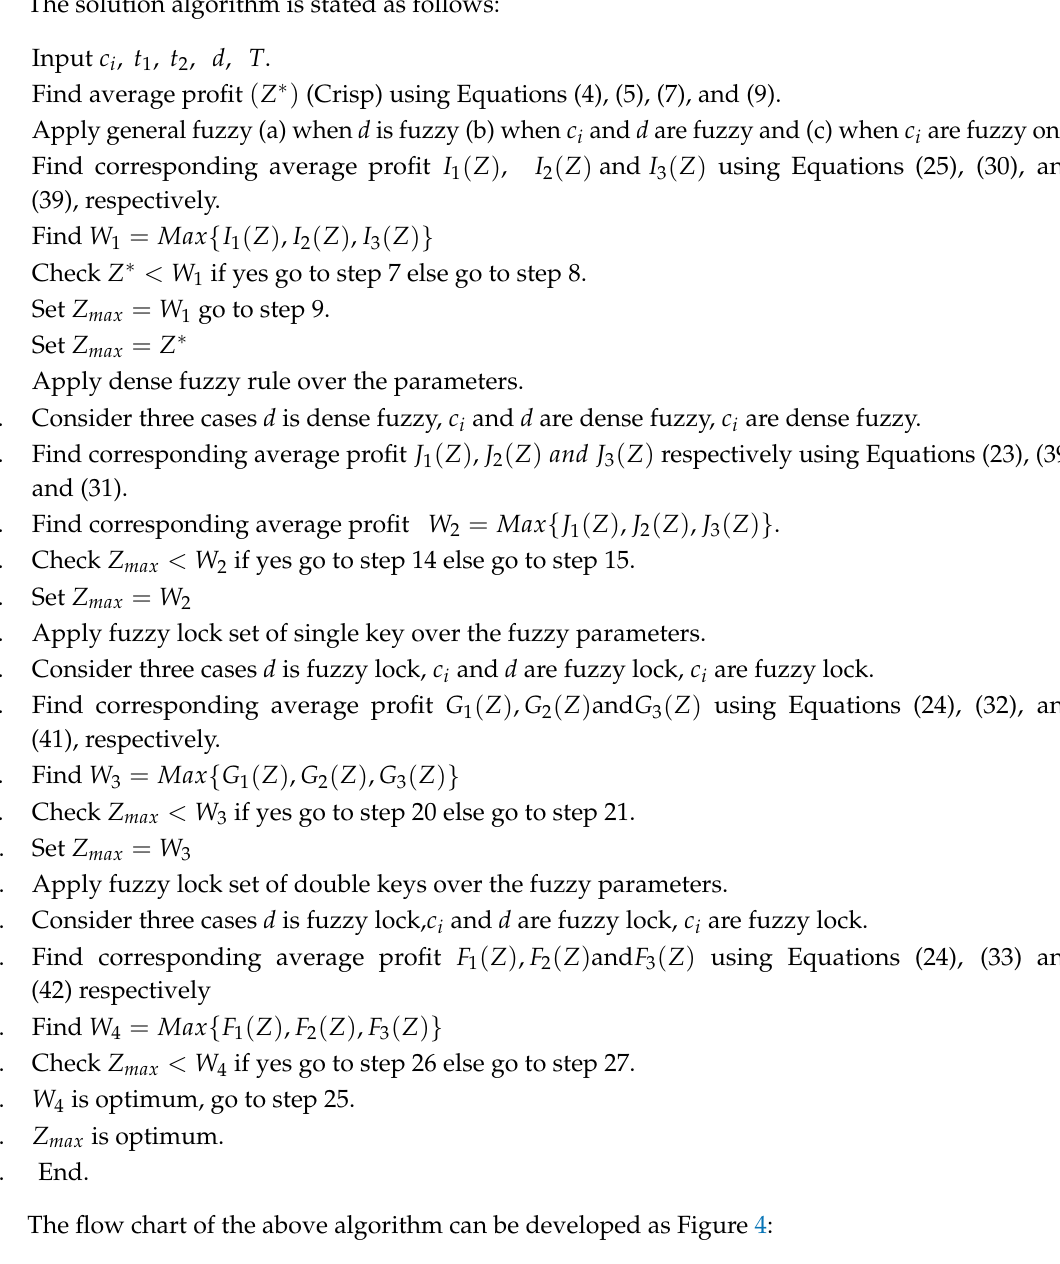
Solution Algorithm and Flow Chart over Dense Fuzzy Lock Set